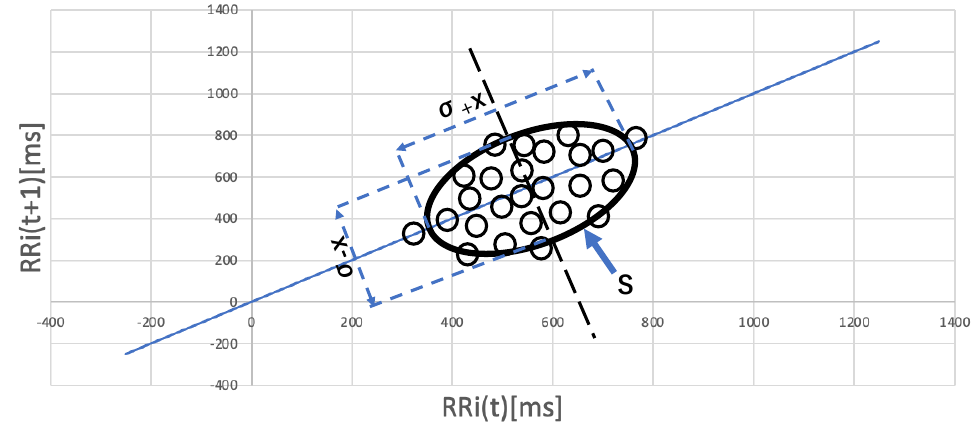
Figure 2. How to calculate the Lorenz plot area.